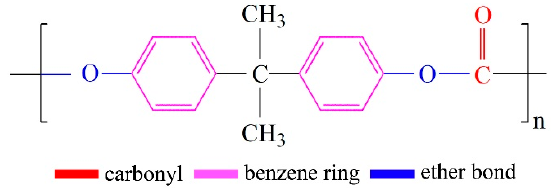
Figure 1. Chemical structural formula of the polycarbonate.